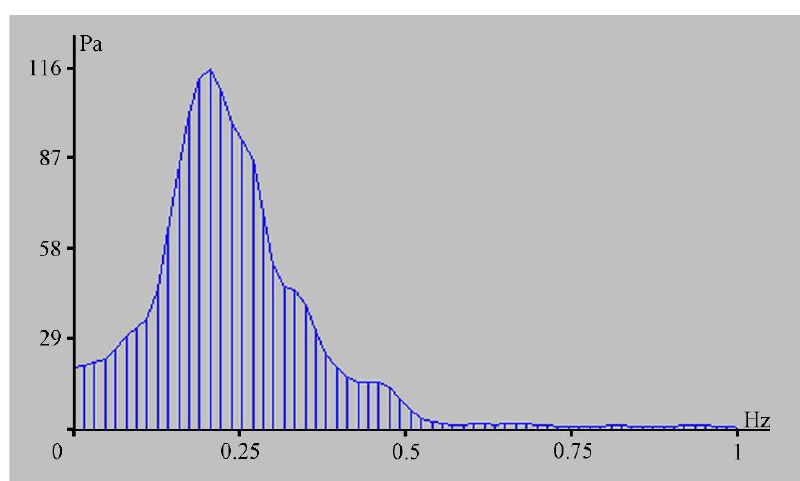
Figure 5. The spectral recording of the disturbance of the supersensitive detector of hydrosphere pressure variations.